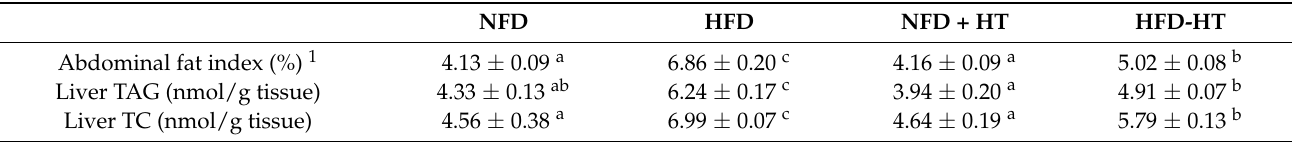
Values are shown as mean ± SE (n = 3). The values with different superscripts (a, b, c) are significantly different at p < 0.05 (Tukey’s test). NFD—normal-fat diet (10% fat); HFD—high-fat diet (16% fat); NFD + HT—NFD supplemented with 200 mg/kg of hydroxytyrosol (HT); HFD + HT—HFD supplemented with 200 mg/kg of HT. 1 Abdominal fat index (%) = 100 × abdominal fat/body